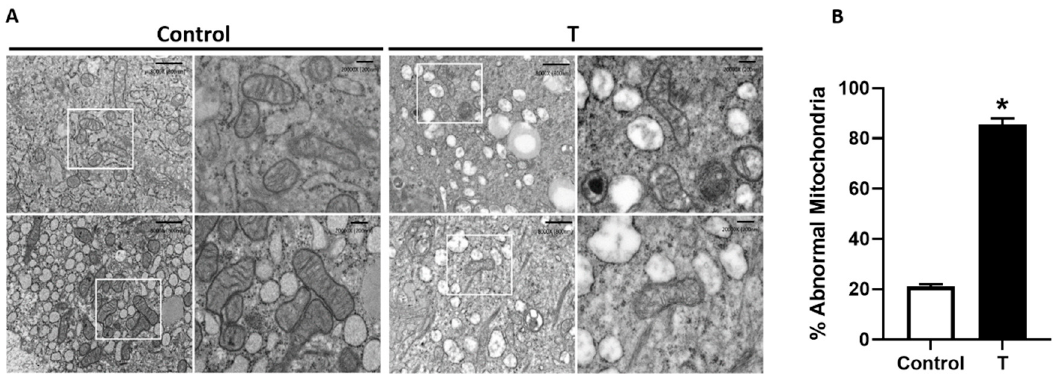
Figure 2. Characterization of mitochondrial structure in the placenta. ( A ) Representative electron micrographs of placental mitochondria from control (left) and T-treated pregnant rats (right). Images show less abundant mitochondria and abnormal mitochondrial structure with condensed matrix and cristae in the placenta of T-treated rats. ( B ) Quantification of the percentage of morphologically abnormal mitochondrial showing condensed matrix and cristae in the placenta of control and T-treated rats. n = 4 in each group. * p < 0.05 vs. control.